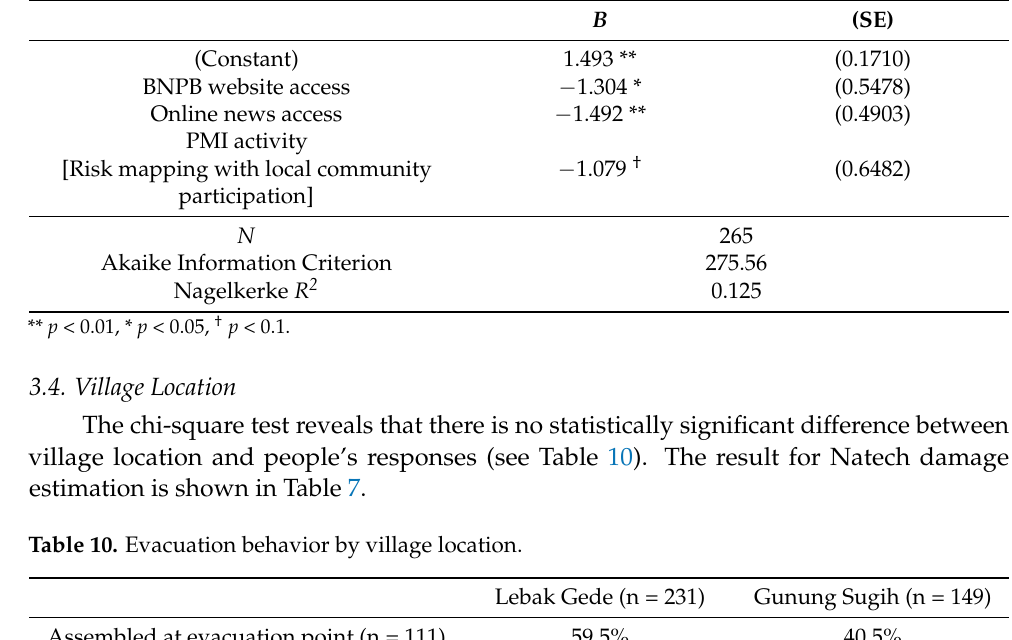
Table 9. Results of logistic regression analysis.